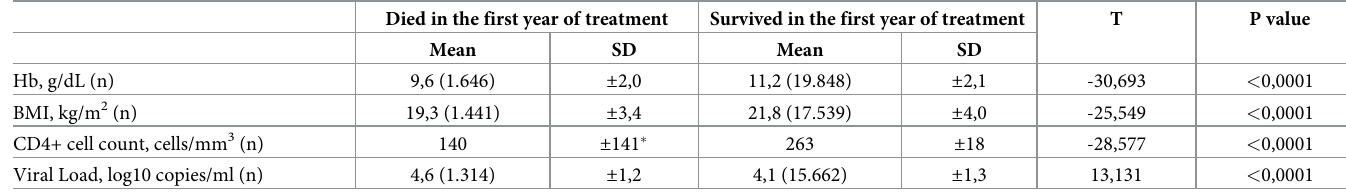
Table 6. Baseline profile of patients with premature